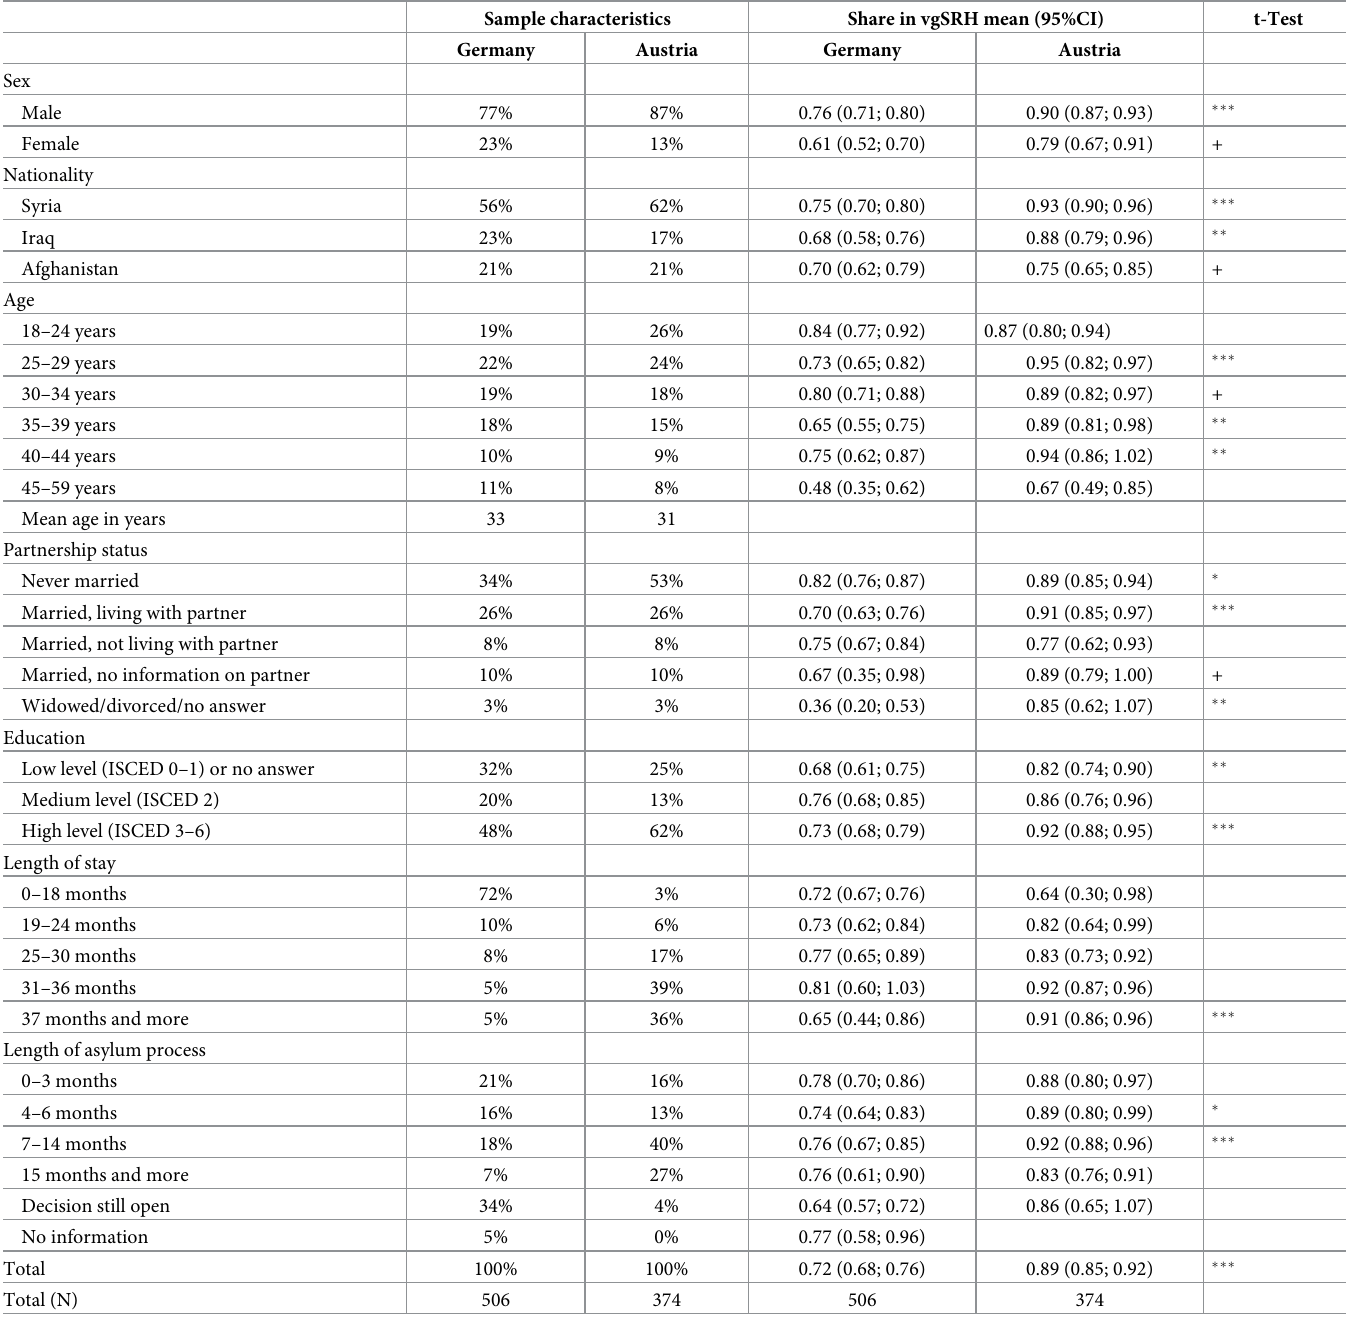
Table 4. Characteristics of matched sample, by country.